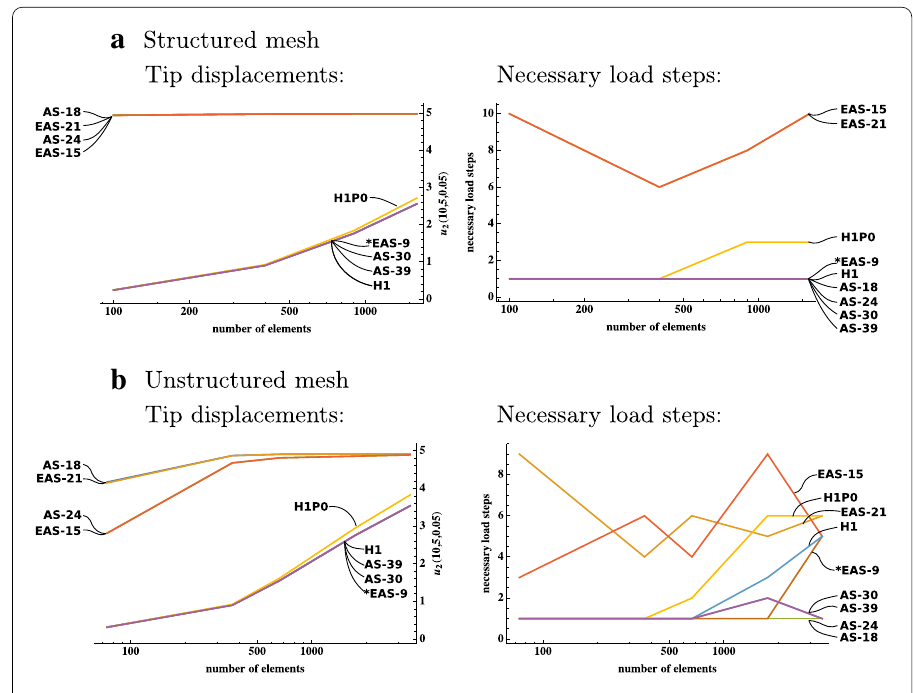
Fig. 11 Bending of a compressible clamped plate; convergence of tip displacement and number of necessary load steps over the number of elements for a structured ( a ) and an unstructured ( b ) mesh refinement